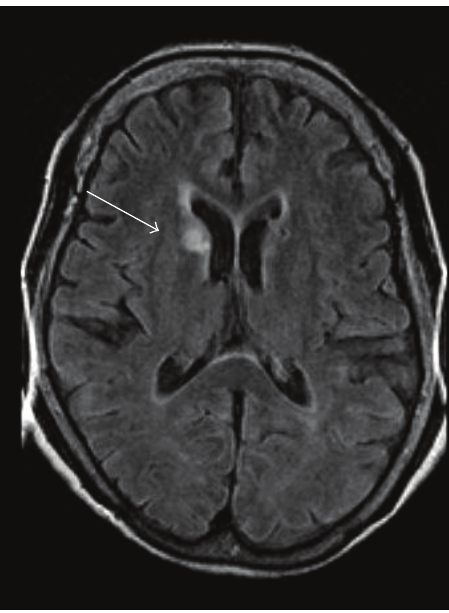
Figure 1: Magnetic resonance imaging of the brain shows a focal lesion in the right caudate head, which shows hyperintensity on fluid-attenuated inversion recovery